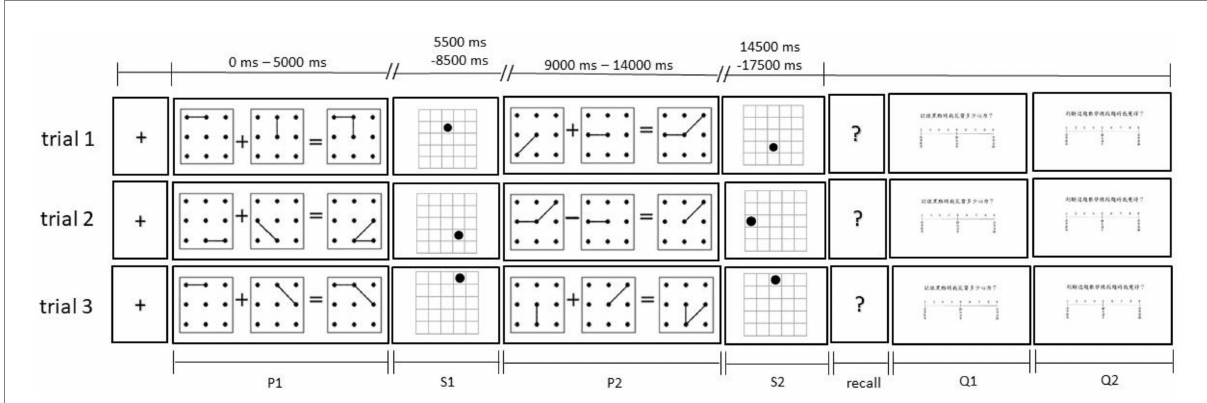
FIGURE 2 Experimental process (taking span 2 of the one-stage equation as an example). P, processing task. S, storage task; 1 or 2 refers to the position of the episodes in the trial. Q1, How much effort did I expend to remember these dots? Q2, How difficult was it for me to verify these equations?